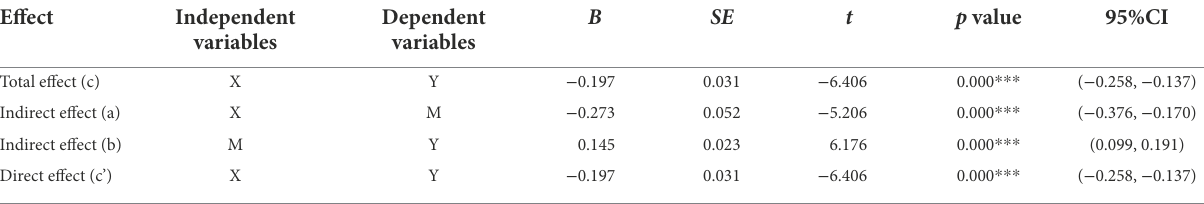
TABLE 7 Summary of the mediating effects of lower extremity muscle strength between mobility and cognitive function.